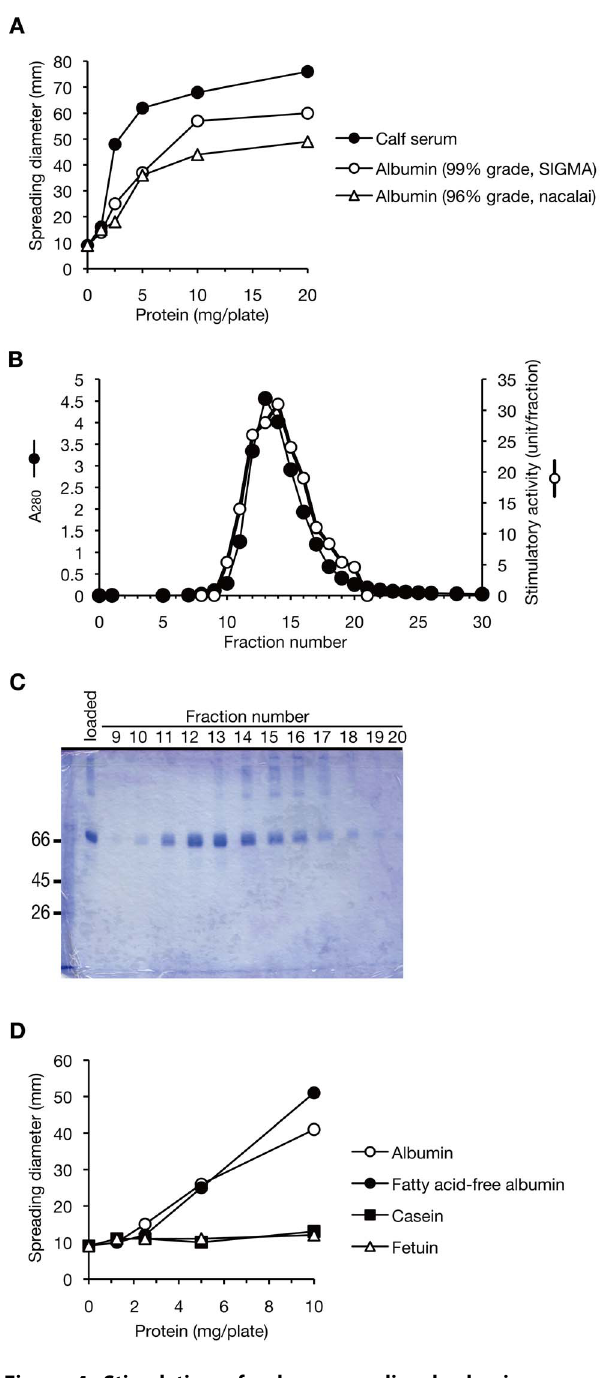
Figure 4. Stimulation of colony-spreading by bovine serum albumin. (A) Colony-spreading stimulation by purified bovine serum albumin. Purified bovine serum albumin of 96% grade (open triangles, Nacalai, cat. no. 01861-26) or 99% grade (open circles, Sigma, cat. no. A0281) was applied to soft agar by 2-fold serial dilution and their colony-spreading stimulatory activities against MRSA NI-15 strain were measured. (B) Elution profile of DEAE-cellulose column chromatography using bovine serum albumin (96% grade, Nacalai). Open circles indicate the colony-spreading stimulatory activity. Filled circles indicate absorbance at 280 nm. (C) SDS-PAGE analysis of DEAE-cellulose column chromatography fractions. The gel was stained with Coomassie Brilliant Blue. The 66-kDa protein coincided with colony-spreading stimulatory activity in fractions 10–20. (D) Bovine serum albumin (Nacalai), fatty acid-free albumin from bovine serum (Wako Chemicals, cat. no.